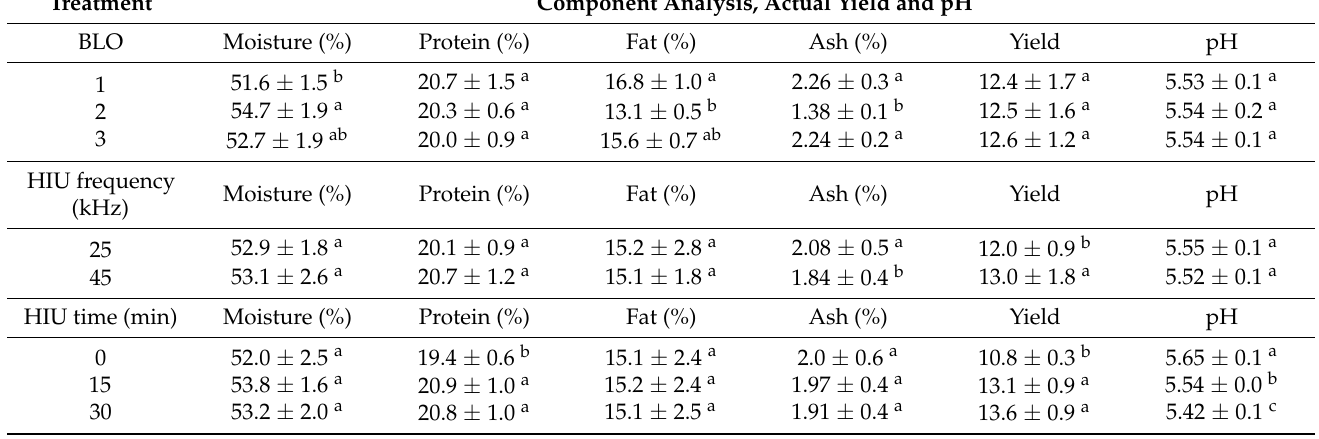
Table 3. Effects of blocks (BLO), HIU (high-intensity ultrasound) frequency, and HIU applied time to fresh raw milk on the moisture, protein, fat and ash content, actual yield (kg cheese/100 L milk), and pH of Oaxaca